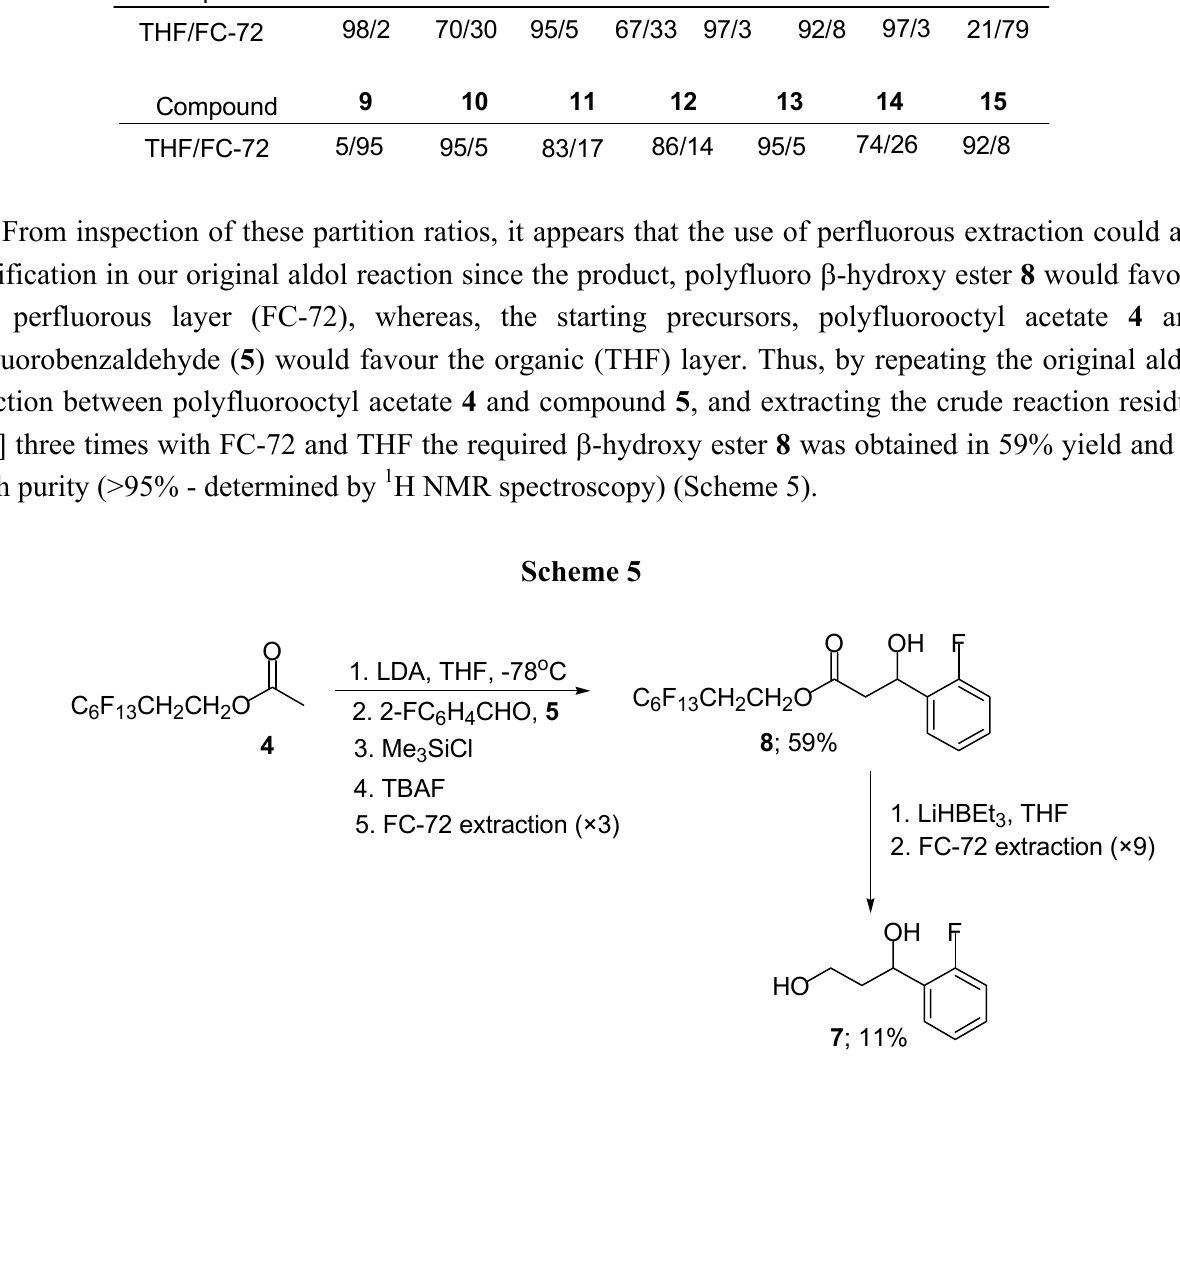
Table 1 : Partition ratio of derivatives between THF and FC-72